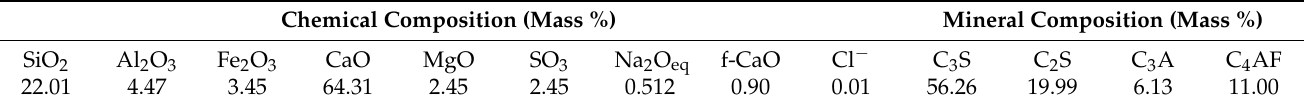
Table 1. Chemical and mineral compositions of the